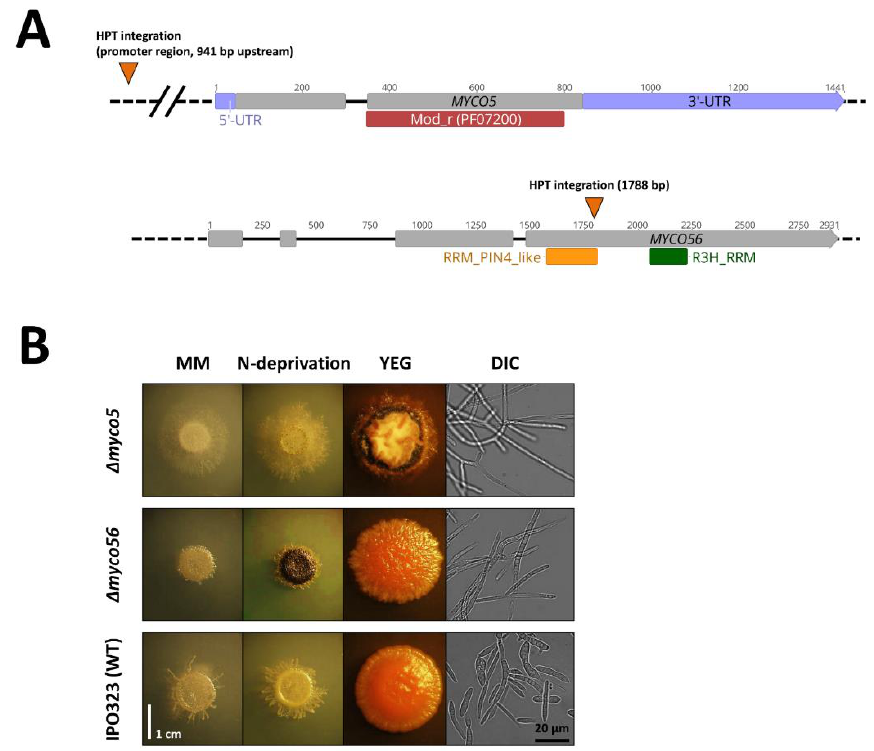
Figure 1. ( A ) Structure of the predicted target genes MYCO5 and MYCO56 and the position of the inserts in the mutants. Sites of T-DNA integration ( HPT ) in the genes are indicated. The numbers indicate the length of the annotated genes. The highlighted bars show the functional domains present in the predicted gene products and found by using InterProScan. Black lines indicate intron, and gray bars indicate exons. ( B ) Phenotypes of the mutants are shown by macroscopic analysis of colony morphology after 21 days’ growth on minimal medium (MM), N-deprivation medium and YEG medium. The micrographs (DIC) indicate the spore morphology following 3 days’ growth in YEG liquid medium.